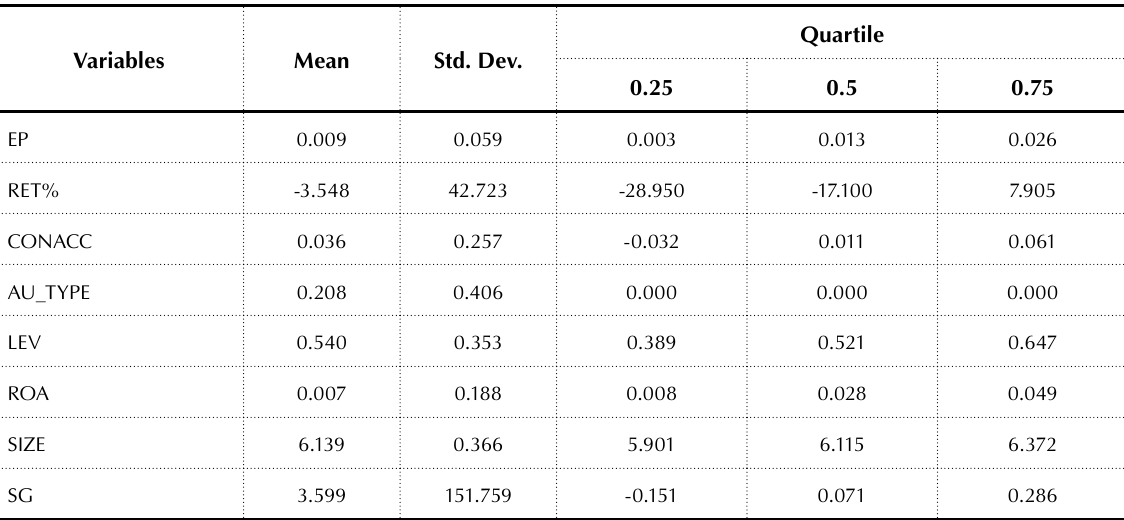
Table 2. Descriptive statistics Panel A: All